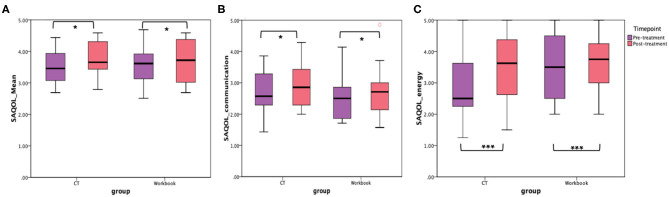
Unadjusted means for (A) SAQOL_mean, (B) SAQOL_communication, and (C) SAQOL_energy for the two groups (CT-R and workbook) pre-treatment and post-treatment. Significant differences are marked with *. *p < 0.05 and ***p = 0.006.